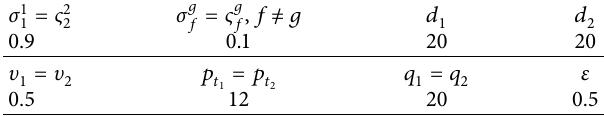
Table 2: Setting used for numerical simulations.